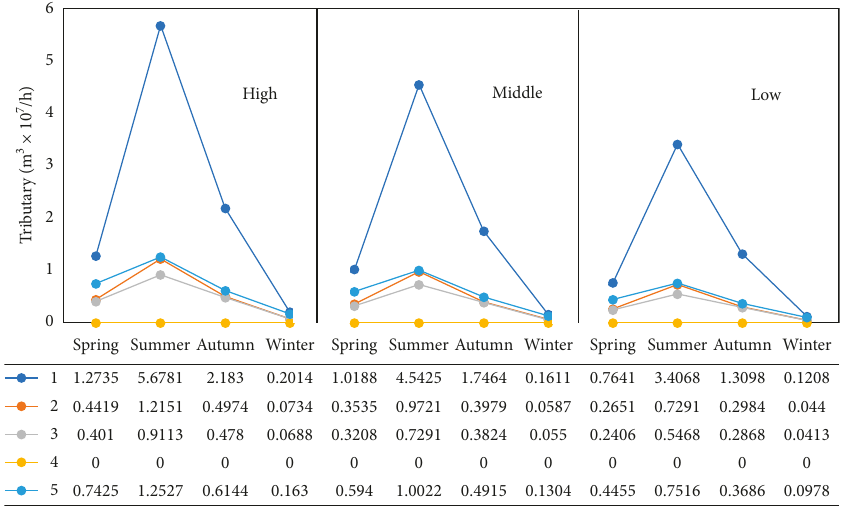
Figure 8: High, middle, low-level tributary in each seasonal stage of each hydropower station